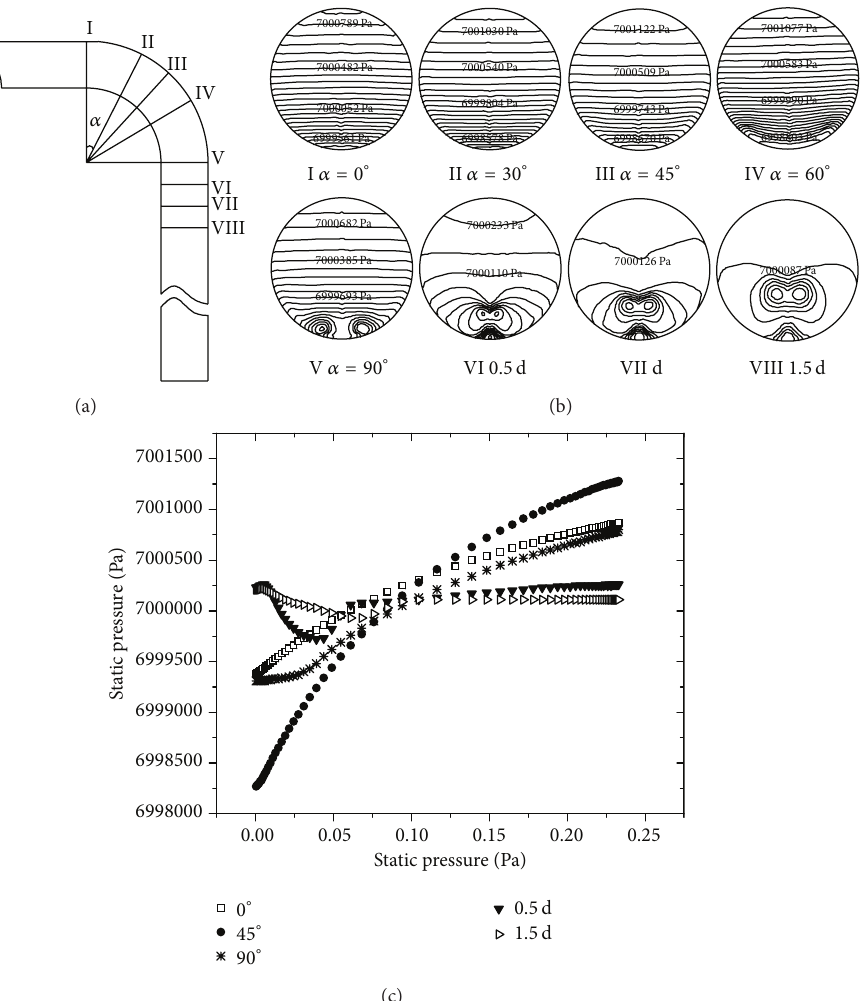
Figure 5: The typical pressure contours of 90 ∘ elbow at various pipe sections for helium gas flow under the condition 250 ∘ C and 7.0MPa (mean velocity V = 24.9 m/s, Re ≈ 1.3 × 10 6 ). (a) Cross section position of a 90 ∘ elbow; (b) static pressure contours of eight cross sections; (c) static pressure distribution along the midline of 90 ∘ elbow in selected planes I, III, V, VI, and